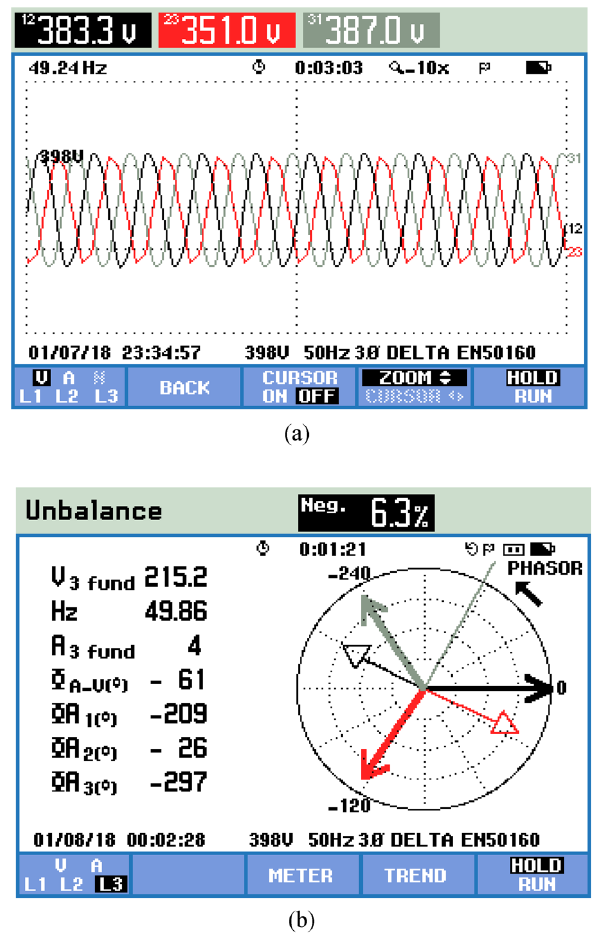
Fig. 6 a Waveform of three-phase generator voltages b voltage unbalance on single-phase side under no-load conditions